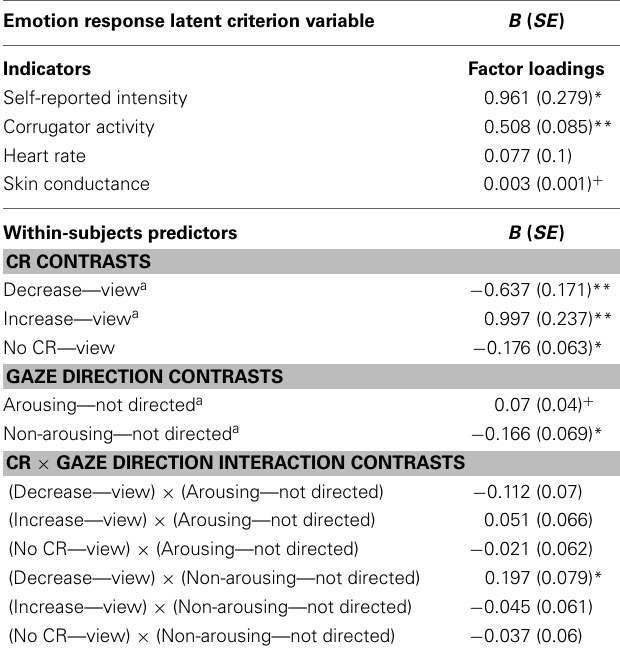
Table 2 | Parameter estimates from preliminary analysis examining cognitive reappraisal and gaze direction effects on emotional